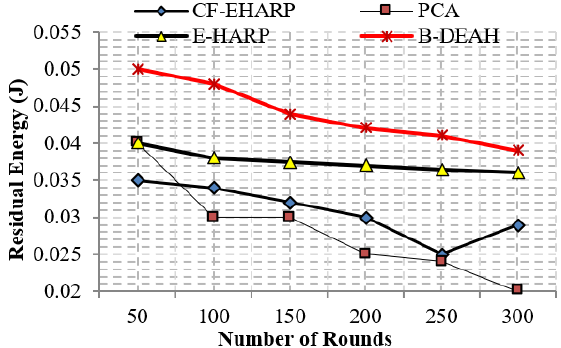
Figure 14. Residual energy vs. simulation rounds (emergency packets).